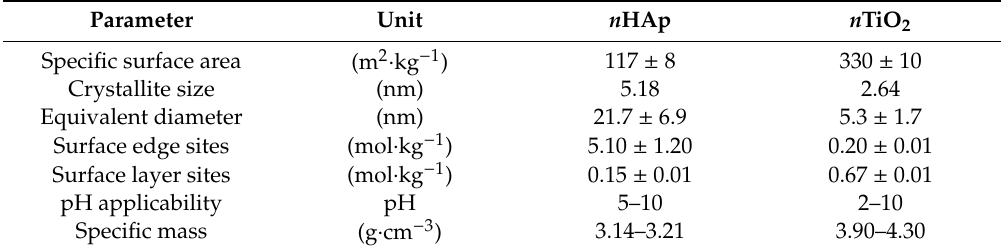
Table 2. The basic properties of n HAp and n TiO 2 [6,10].